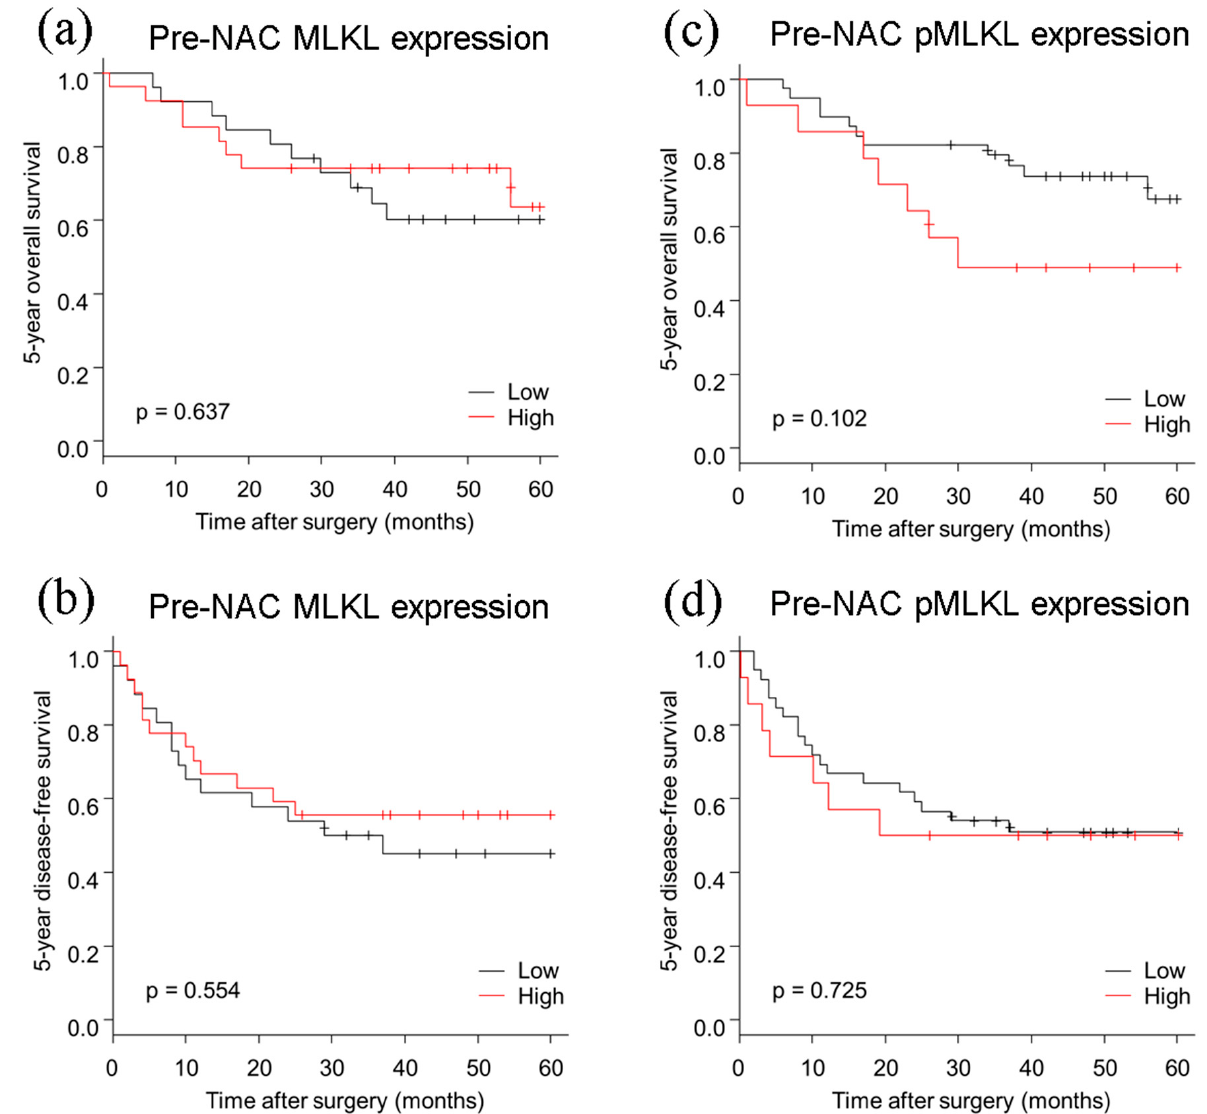
Figure 3. Kaplan–Meier curves based on pre-NAC MLKL and pre-NAC pMLKL status. ( a , b ) No significant difference was detected in pre-NAC MLKL status for the 5 year OS and DFS. ( c ) The 5 year OS tended to be worse in patients with high pMLKL status than in those with low pMLKL, but this difference did not reach statistical significance. ( d ) No significance was detected in pre-NAC pMLKL status for the 5 year DFS. Abbreviations: MLKL, mixed lineage kinase domain-like protein; pMLKL, phosphorylated MLKL; OS, overall survival; DFS, disease-free survival; NAC, neoadjuvant chemother- apy. Table 5. Univariate analysis of patients’ 5 year overall survival based on the pre-NAC status of the markers. Variable